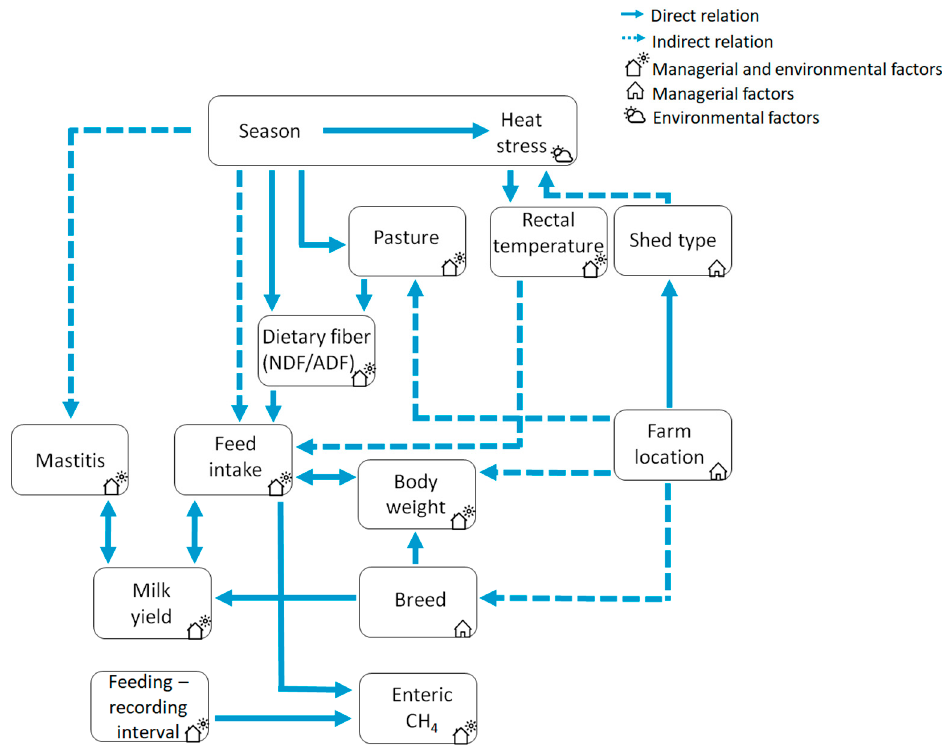
Figure 1. Conceptual framework depicting the relations of spatial, managerial and environmental factors with enteric methane emission across a rural-urban interface.